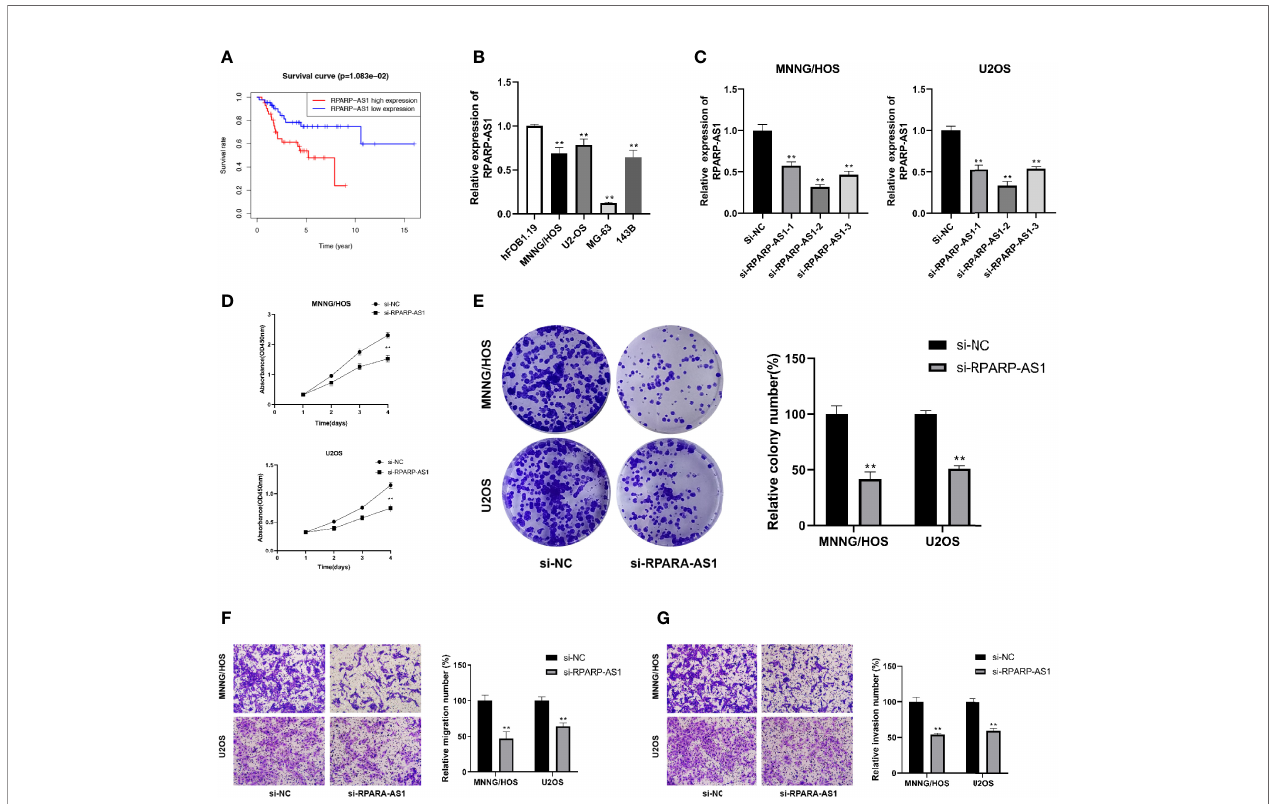
FIGURE 11 | Downregulation of RPARP-AS1 inhibited osteosarcoma cell growth migration, and invasion. (A) Survival analysis of osteosarcoma patients with high and low RPARP-AS1 expression. (B) RPARP-AS1 expression in osteosarcoma cell lines and osteoblast cell line. (C) Transfection ef fi ciency of si-RPARA-AS1 in MNNG/HOS and U2OS cells. (D, E) CCK-8 (D) and colony formation (E) assays were utilized to detect the proliferative capacity of MNNG/HOS and U2OS cells after RPARP-AS1 downregulation. (F, G) Transwell assays were applied to determine the migration (F) and invasion (G) capacity of MNNG/HOS and U2OS cells after RPARP-AS1 downregulation (magni fi cation, 100×). **p <